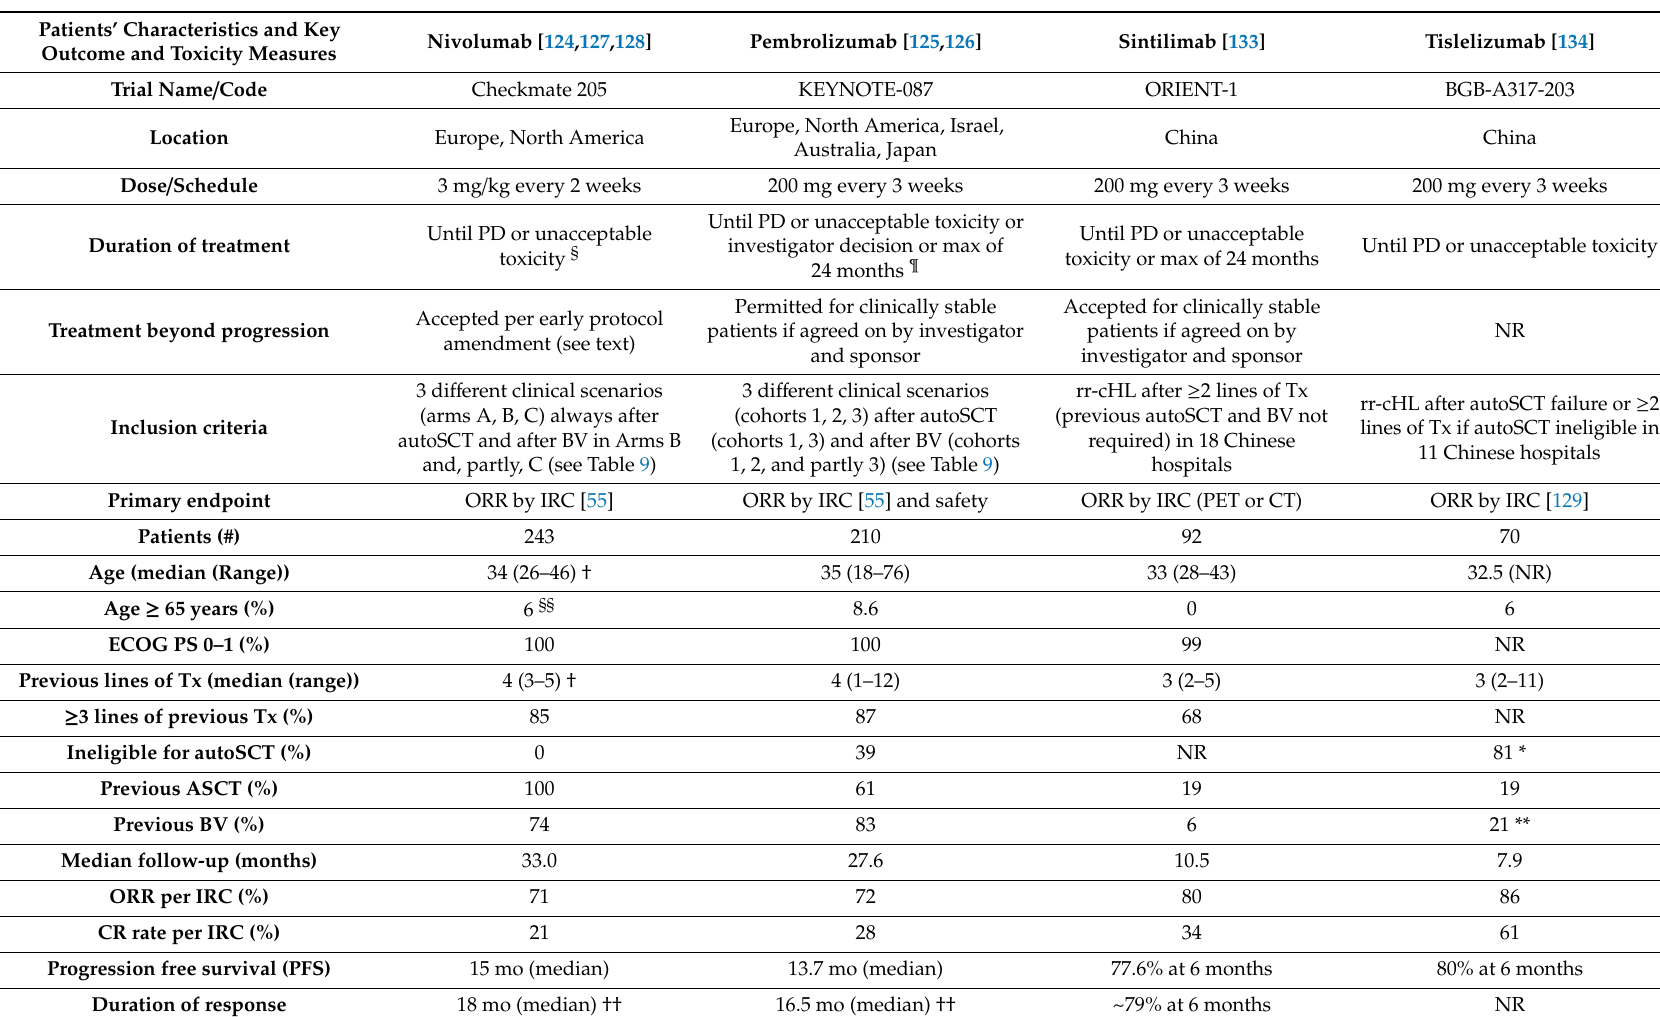
Table 8. Comparison of patients’ characteristics and overall results for nivolumab, pembrolizumab, sintilimab, and tislelizumab phase II trials for rr-cHL. Patients’ Characteristics and Key Outcome and Toxicity